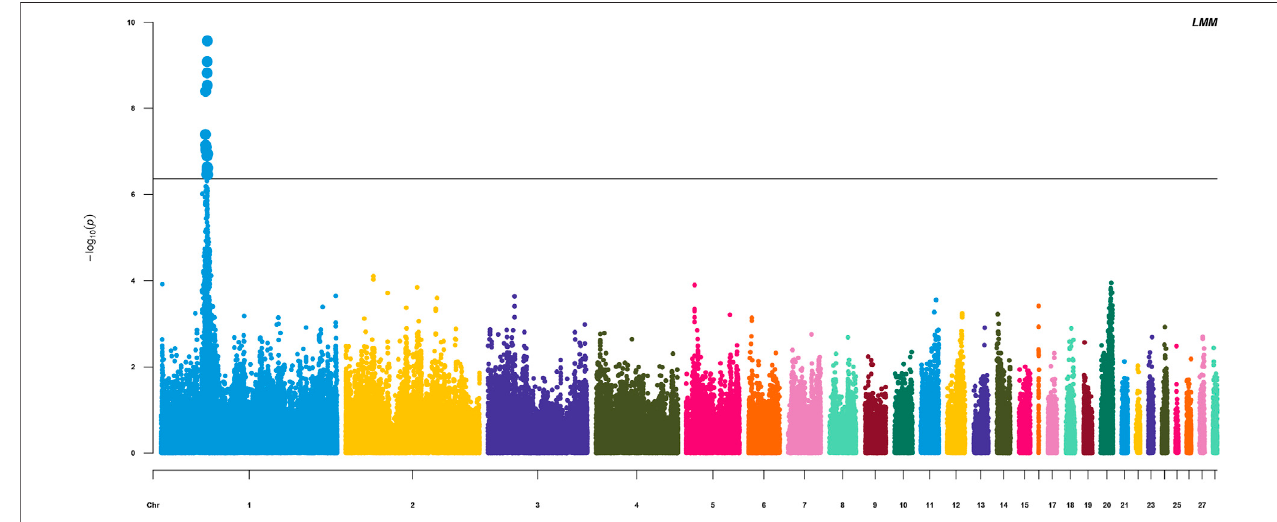
FIGURE 4 | Manhattan plots for analyzing the results of HVP. Signi fi cant SNP loci are indicated in bold.